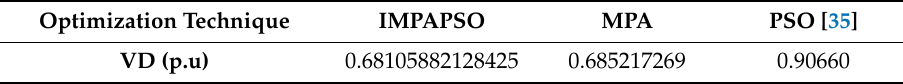
Table 7. IEEE 57-bus system’s second case objective